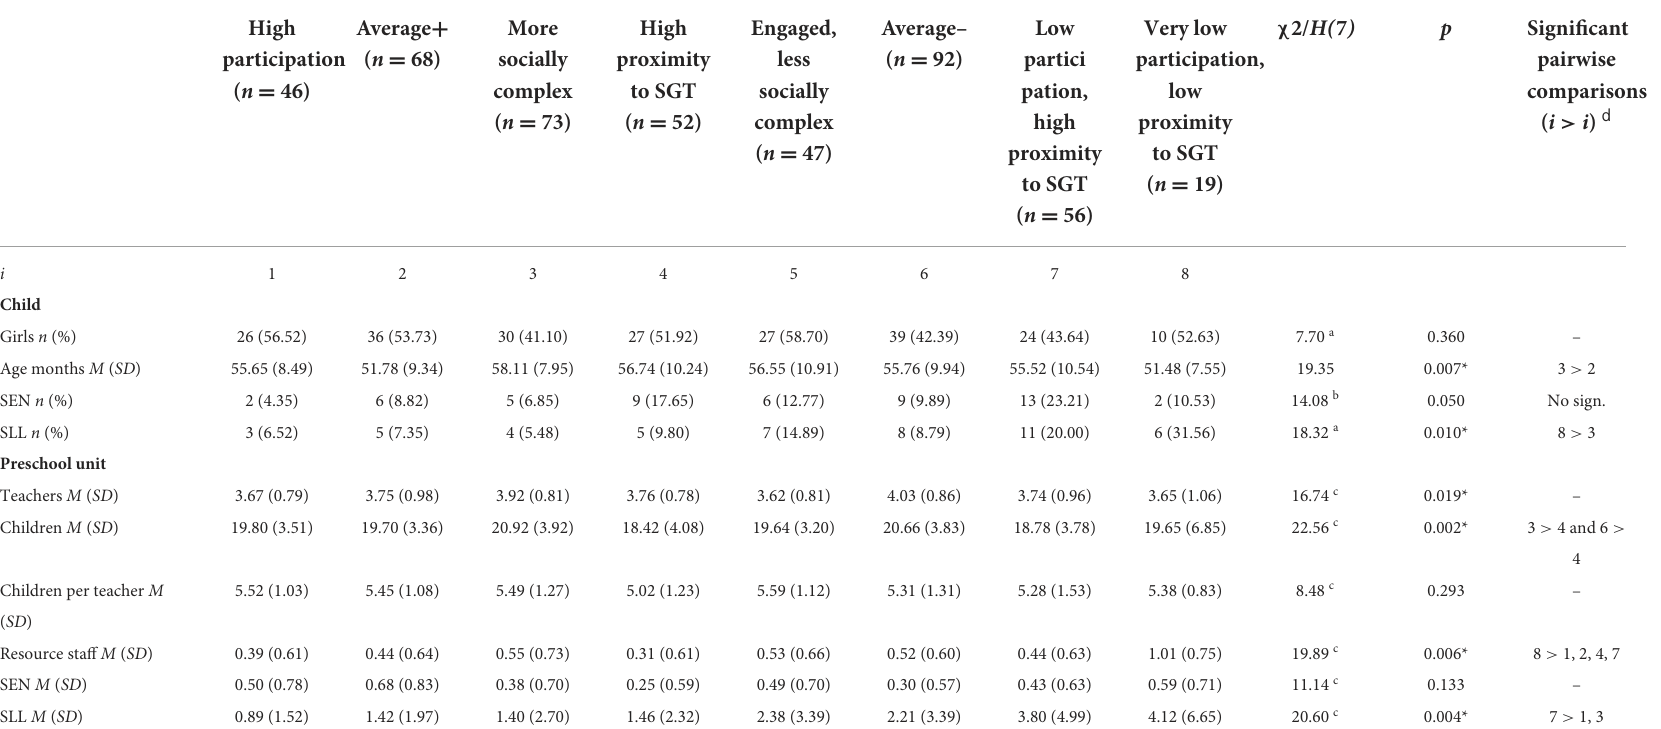
TABLE 4 Differences in child and preschool unit characteristics by clusters ( N =